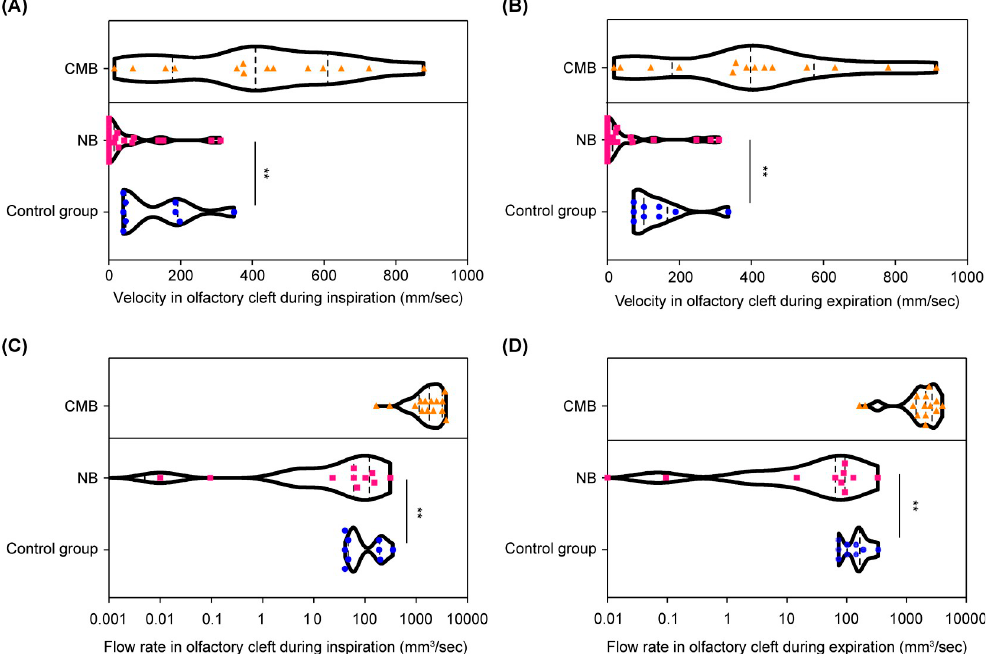
Fig 2. Velocity and flow rate in the olfactory cleft during inspiration and expiration for the combined mouth breathing (CMB), nasal breathing (NB), and control groups. a . The velocity in the olfactory cleft at maximum flow during inspiration. b . The velocity in the olfactory cleft at maximum flow during expiration. c . The flow rate in the olfactory cleft at maximum flow during inspiration. d . The flow rate in the olfactory cleft at maximum flow during expiration. The CMB group is presented as reference values. Comparison between the NB and control groups revealed a significant difference: �� p < 0.01.